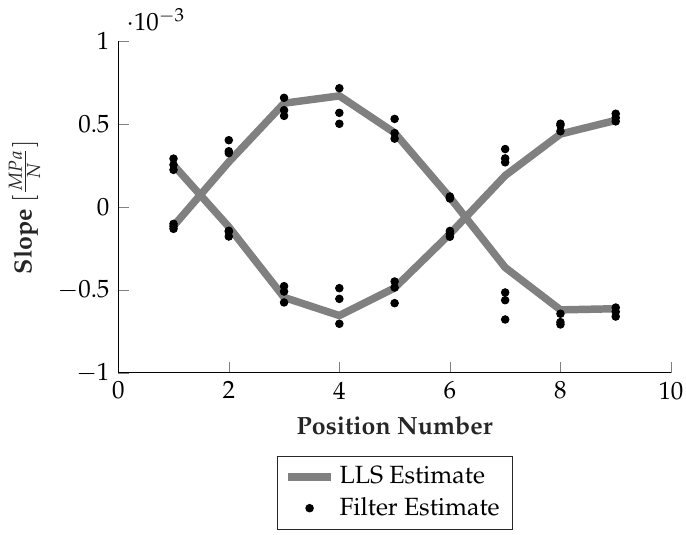
Figure 13. Slope estimation